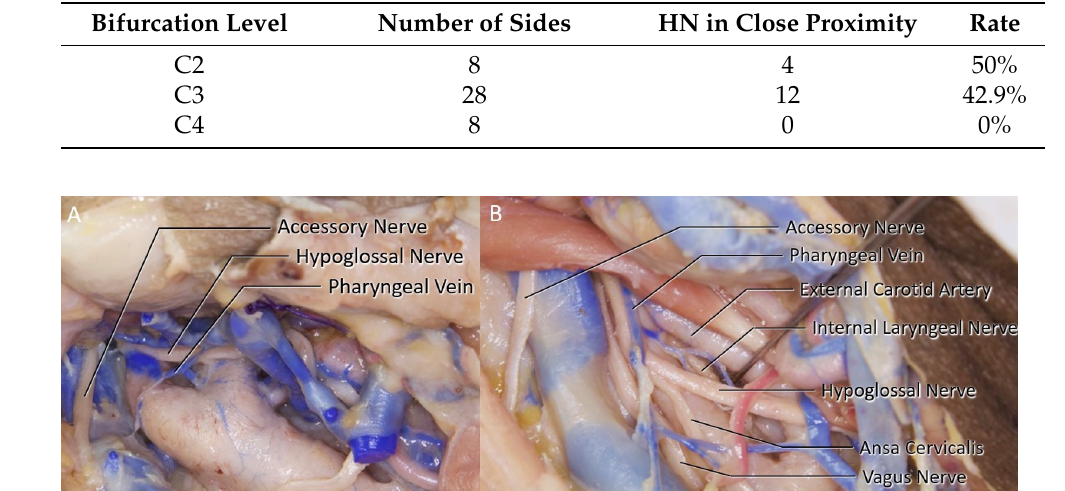
Table 3. Carotid Bifurcation level and the rate of having a HN in proximity.